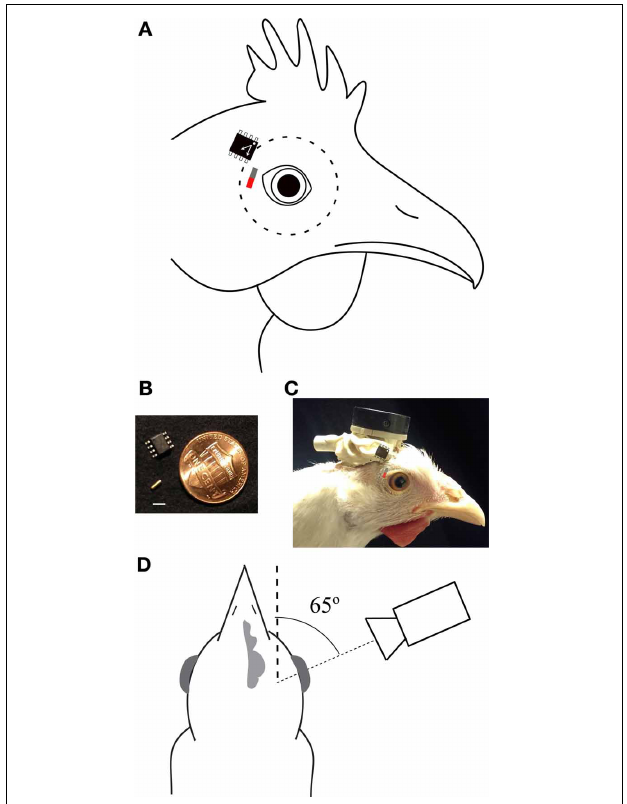
FIGURE 1 | Preparation. (A) Optimal positions and orientations of sensor and magnet (red/gray bar). The dashed line indicates the extent of the eyeball. (B) The magnet (gold cylinder) and sensor in comparison to a U.S. penny. Scale bar is 3mm. (C) Picture of a chicken with the magnetic tracking system implanted (neither is directly visible). The locations of the underlying magnet and sensor are overlaid using the same convention as in panel (A) . The head plate to which the sensor is attached and the Omnetics connector through which power is provided and sensor voltages recorded are apparent. (D) A schematic of the optical recording arrangement. The camera was aligned with the pupillary axis (fine dashed line), 65 ◦ lateral to the parasagittal plane of the head (coarse dashed line). Distances are not to